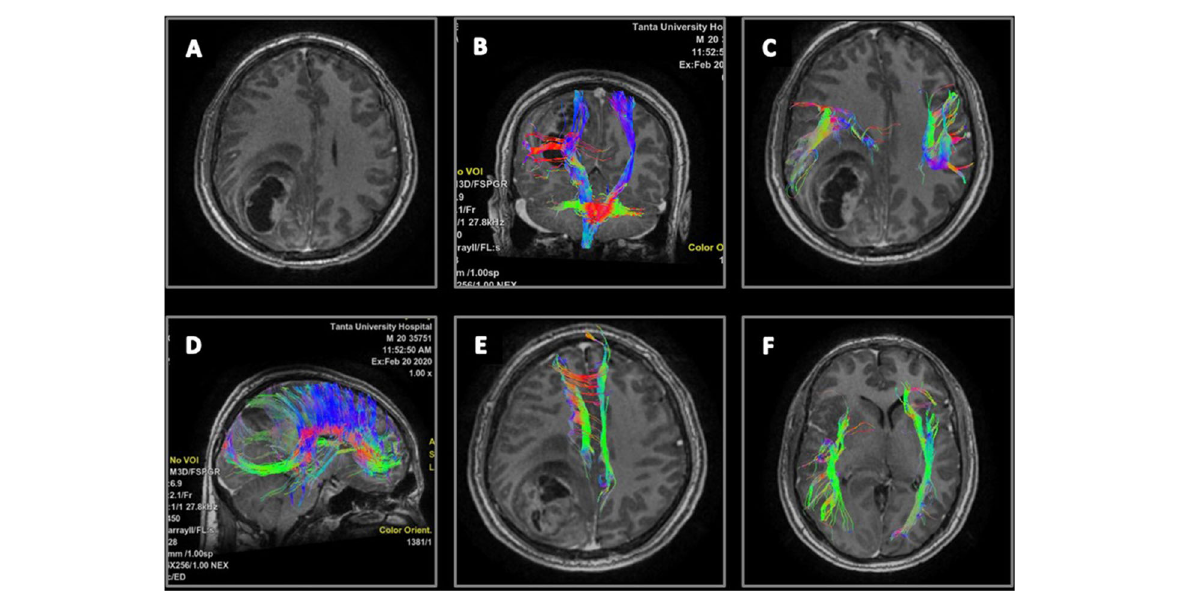
Fig. 5 Case number 3. A 20 years old male patient presenting with headache and left side hemiparesis. Pathologically proven glioblastoma, high grade. a Axial T1 WI with contrast revealing a right parieto-occipital mixed solid and cystic SOL with faint heterogeneous post contrast enhancement surrounded by grade I vasogenic edema. b Coronal T1 WI with 3D reconstruction of the CST tracts. Pattern VI displacement, splaying, and fiber attenuation of the right CST related to the tumor compared to intact left CST. c Axial T1 WI with 3D reconstruction of the SLF. Pattern II antero-lateral displacement and mild decreased FA of the right SLF. Axial T1 WI with 3D reconstruction of d the corpus callosum tracts, e the cingulum tracts, and f the ILF tracts revealing pattern II displacement and splaying of CC shows mild decreased FA and mild increased ADC. Pattern III fibers attenuation of right cingulum and right ILF showing mild decreased FA and mild increased ADC